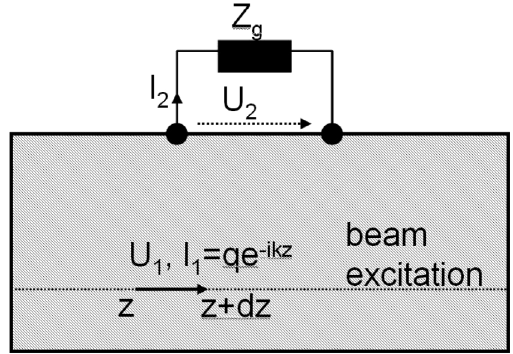
(cid:6) E d z is z 1 (cid:6) 1 (cid:6) U =Z , we have I as the respec- g g 2 2